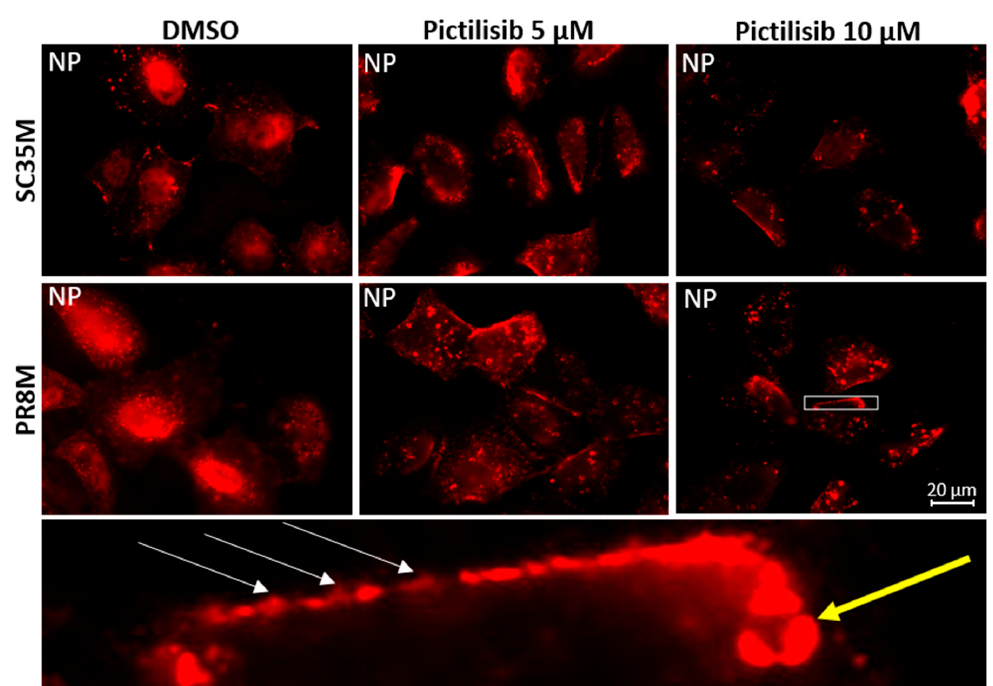
Figure 4. Viral internalization is impaired upon Pictilisib treatment. A549 cells were pre-incubated for 2 h with DMSO or Pictilisib (5 µM or 10 µM) in DMEM and infected with recombinant SC35M or PR8M (MOI 200). Staining was performed with primary antibody against NP. The figure is representative for three independent experiments. White arrows show virus particles at the cell border; the yellow arrow shows a large accumulation of NP in the cytoplasm. Acquired with Axiovert200M, scale bar represents 20 µm